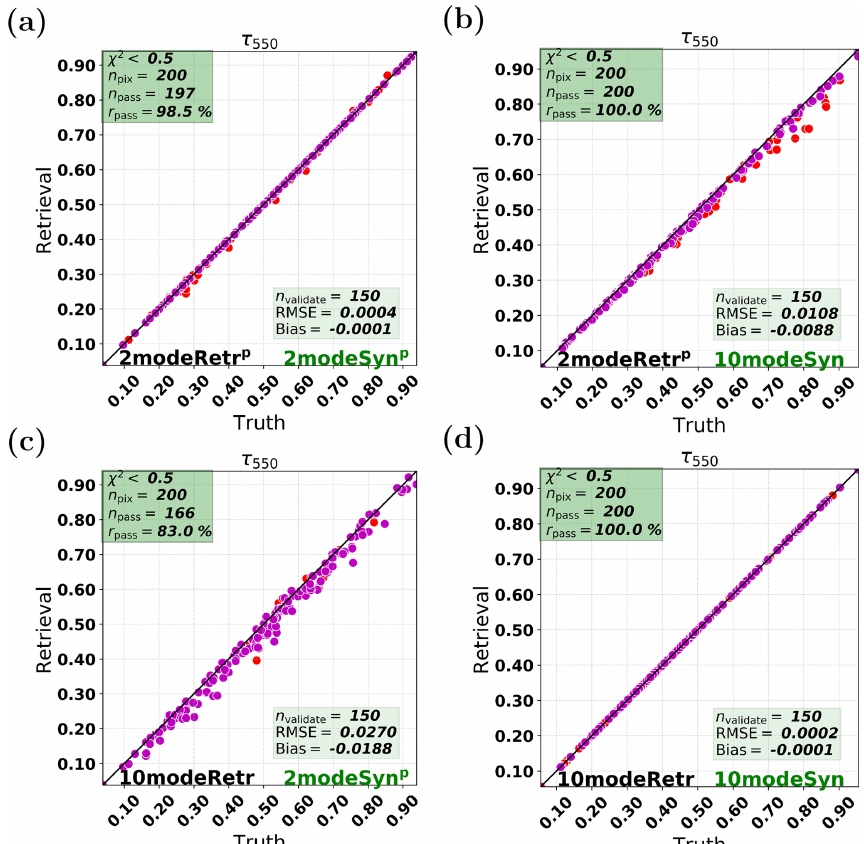
Figure 1. Synthetic retrievals: aerosol optical thickness (AOT) with the parametric two-mode retrieval (2modeRetr p ) and the 10-mode retrieval (10modeRetr). The red and magenta points represent n pass and n validate points, respectively. The measurements are the parametric two-mode synthetic measurement (2modeSyn p ) and the 10-mode synthetic measurement (10modeSyn). (a) 2modeRetr p on 2modeSyn p . (b) 2modeRetr p on 10modeSyn. (c) 10modeRetr on 2modeSyn p . (d) 10modeRetr on